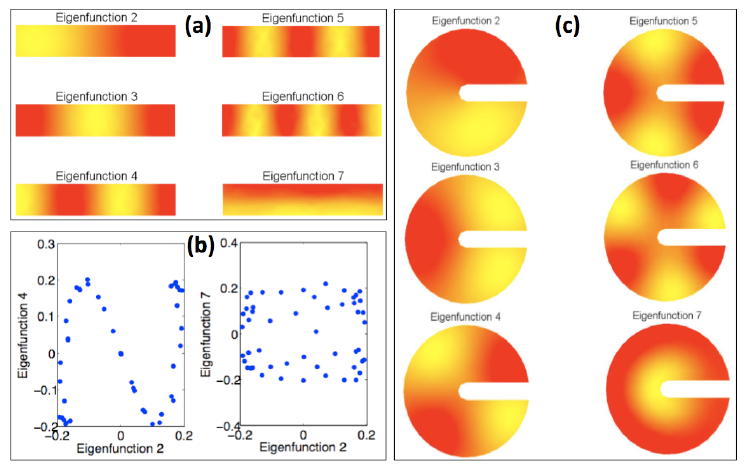
Figure 3. The analogy between traditional diffusion on domains and diffusion on graphs from sampled data. ( a ) The solution to the finite element method (FEM) formulation of the PDE (partial differential equation) eigenvalue problem ∇ 2 φ = λφ with no flux boundary conditions is reported for a narrow two-dimensional rectangular stripe. The second and seventh eigenfunctions are found to be uncorrelated and suitable to parametrize the two relevant dimensions of the manifold; ( b ) Entries in the first non-trivial eigenfunction of the problem in figure (a) vs . entries in the fourth eigenfunction (sampled at scattered locations of the computational domain) reveals a strong correlation between those two functions: the fourth eigenvector (which we know corresponds to the third harmonic, cos (3¯ x ) ) does not encode a new direction on the data manifold. Right-hand side : Entries in the first non-trivial eigenfunction of the problem in (a) vs . entries in the seventh eigenfunction (at the same scattered locations) confirms that the seventh eigenvector (which we know corresponds to cos (¯ y ) , encodes a new, second direction; ( c ) A different domain, but the same premise: The solution to the finite element method (FEM) formulation of the PDE (partial differential equation) eigenvalue problem ∇ 2 φ = λφ with no flux boundary conditions is reported for a two-dimensional manifold with a complicated boundary. The second and seventh eigenfunctions are found to be uncorrelated and suitable to parametrize the two relevant dimensions of the manifold (an “angular” and a “radial”